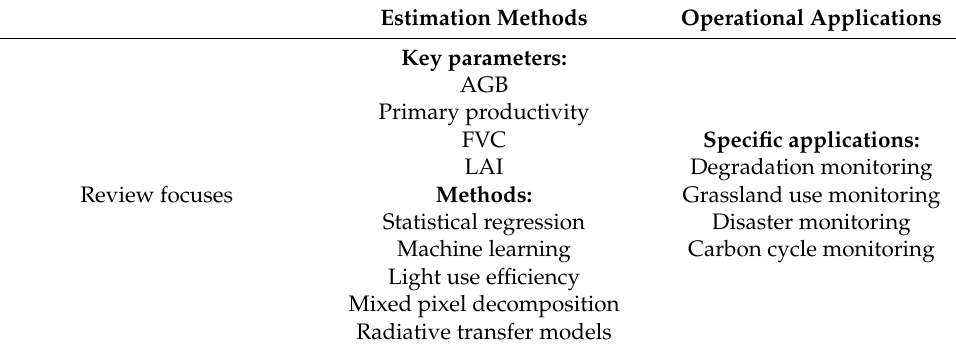
Table 1. Topics reviewed in this